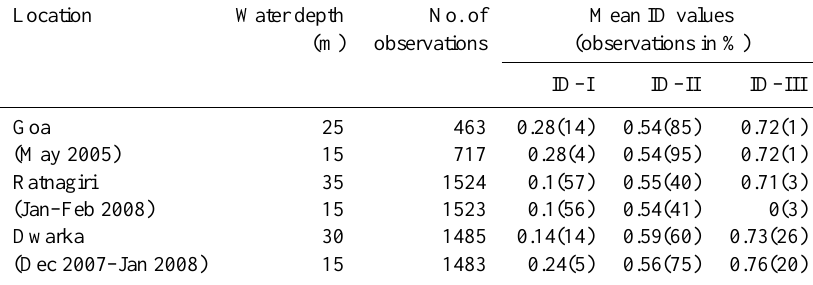
Table 3. Percentage of intermodal distance (ID) along the west coast of India.